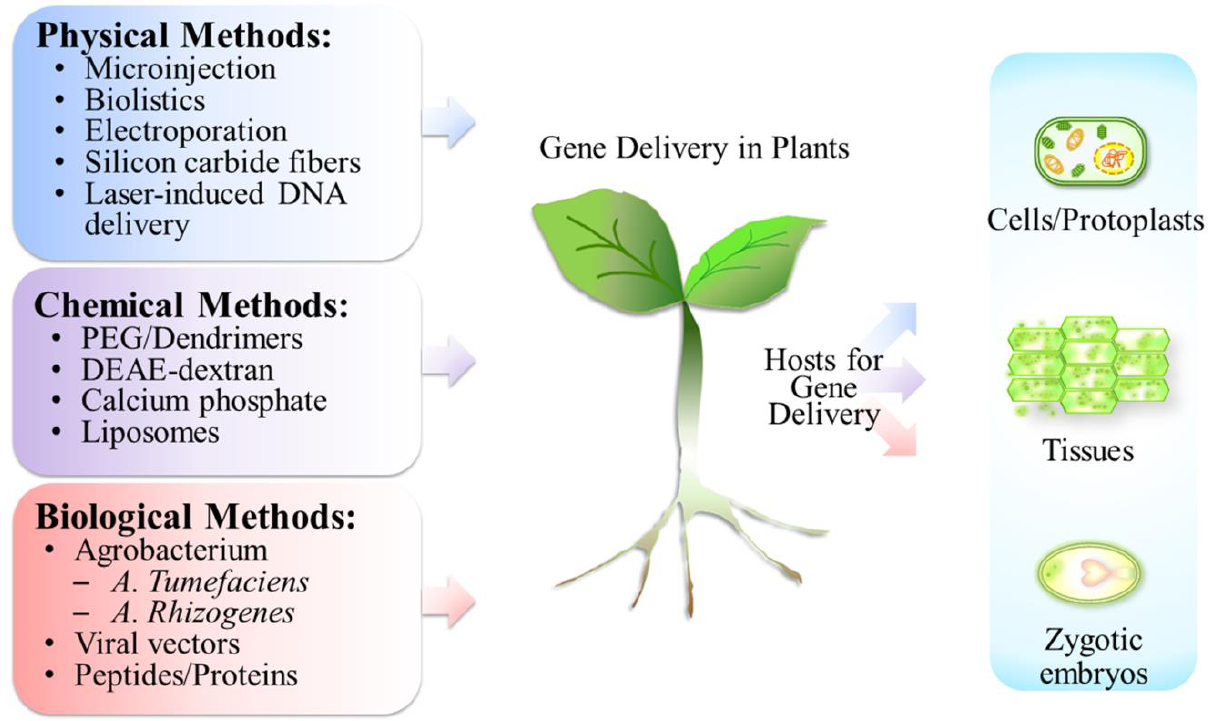
Figure 1. Methodologies of gene delivery in plants. Various methods including physical, chemical, and biological manners were applied in gene delivery. Plant cells were prepared as protoplasts for gene uptake. Plant tissues (callus) and zygotic embryos also served as the transgenic hosts. PEG: polyethylene glycol; DEAE: diethylaminoethanol.